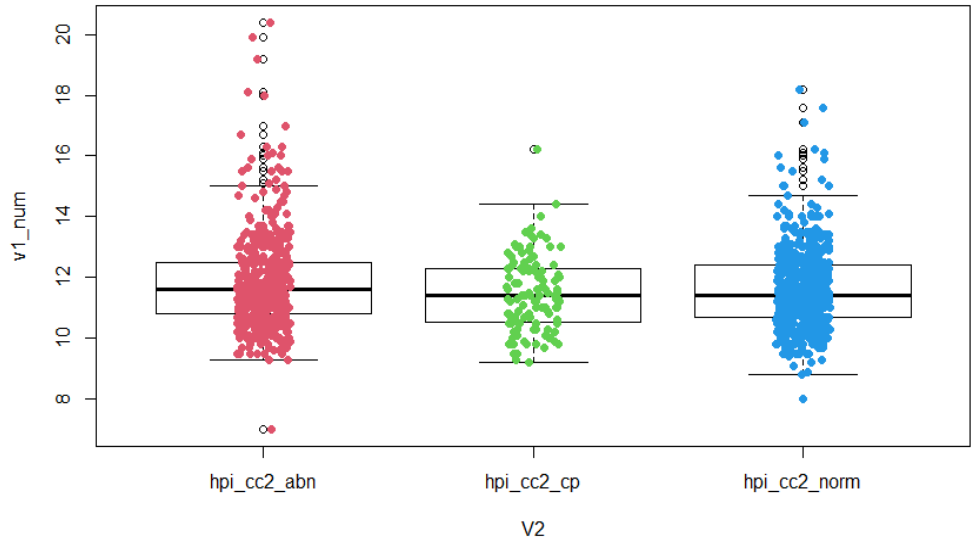
Figure 1. Time-lapse distribution—cc2 in groups of PGT-A abnormal embryos, normal embryos with proven clinical pregnancy and normal embryos. Boxplot is categorized by groups: abn—PGT-A abnormal embryos, cp—PGT-A normal embryos with clinical pregnancy, norm—PGT-A normal embryos, hpi = hours post insemination, v1_num = numerically expressed time, v2 = identification of grouped variables containing the type of embryo.